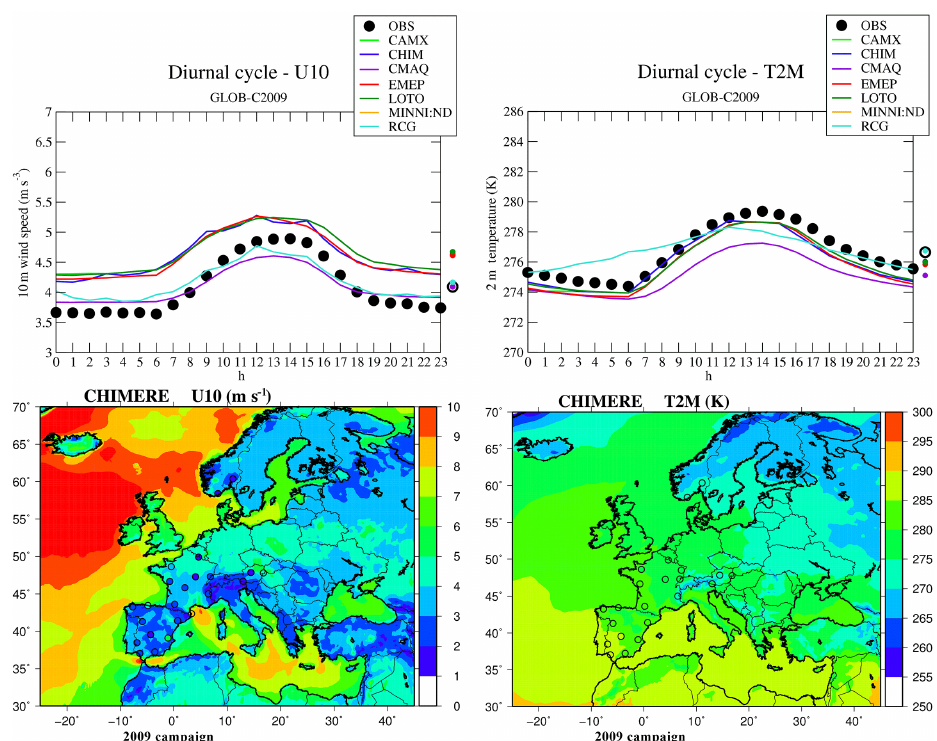
Figure 1. Comparisons of observed vs. predicted meteorological variables (U10, T2M) for the 2009 campaign. Top left panel: mean diurnal cycle of the 10m wind speed; top right panel: mean diurnal cycle of the 2m temperature; bottom left panel: mean 10m wind speed for CHIMERE; bottom right panel: mean 2m temperature for CHIMERE. Some observations at EMEP stations are provided with coloured circles over the maps. Red colour is assigned for values exceeding the colour